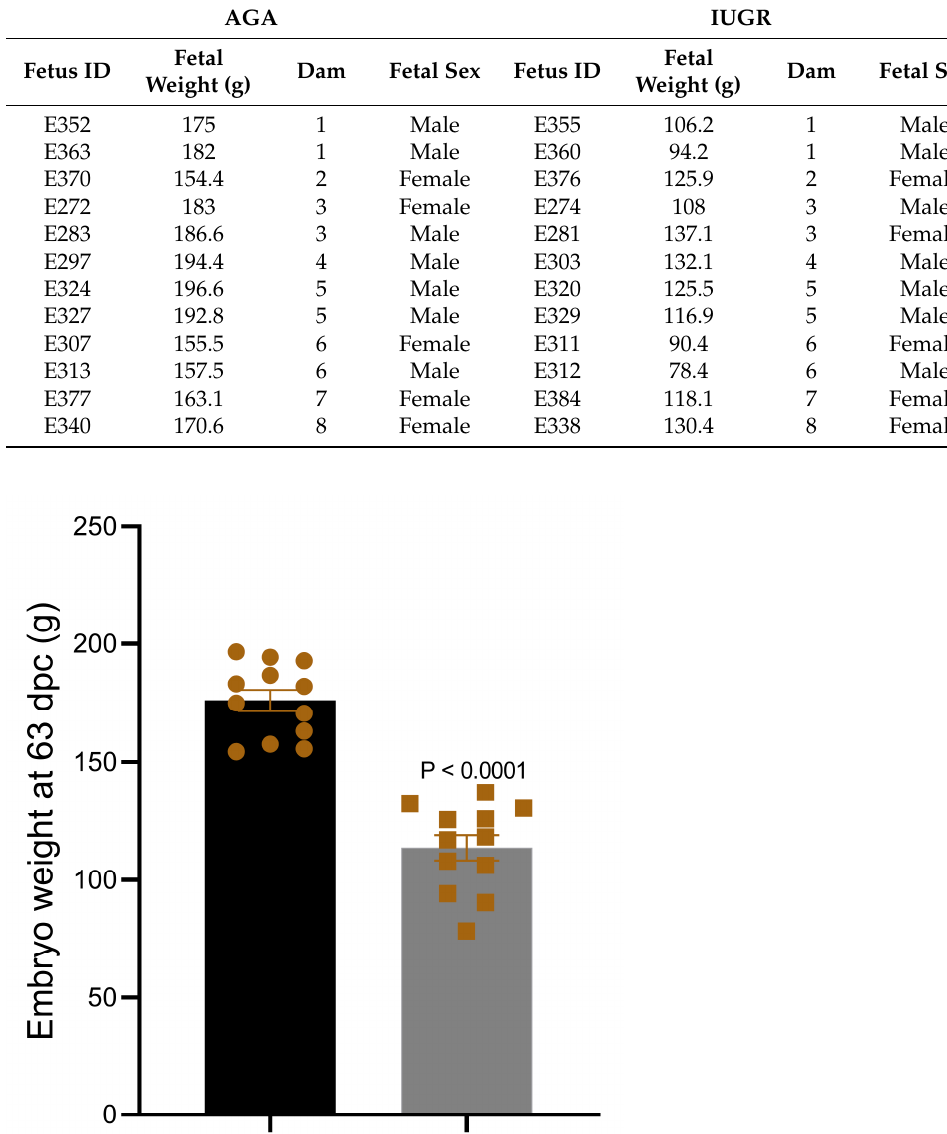
Table 1. Phenotype of fetuses in AGA and IUGR groups from one sire and eight dams.